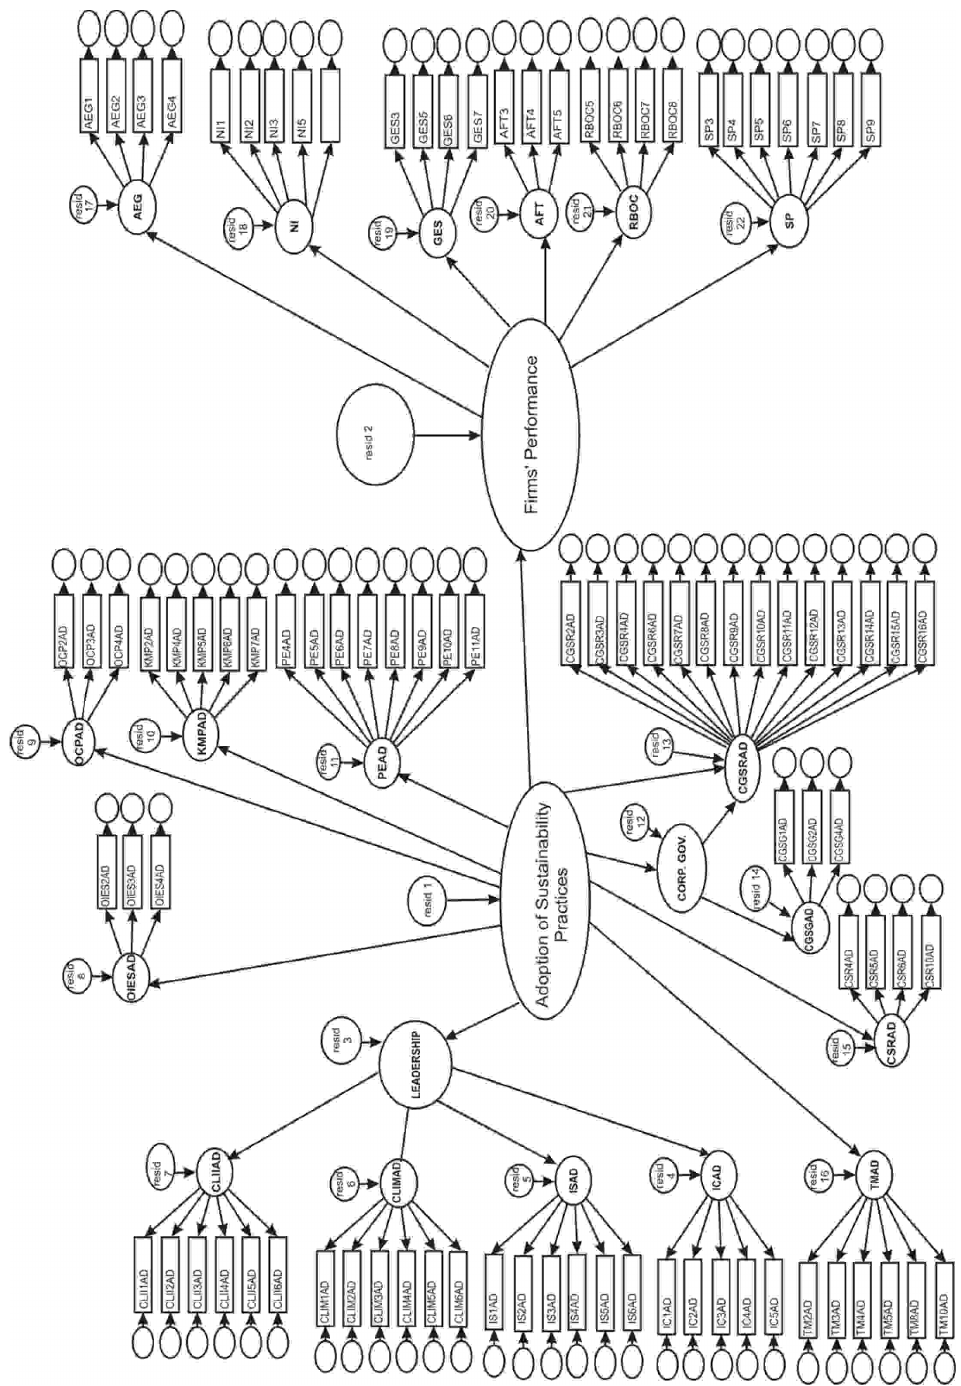
Fig. 3. Hypothesized structural equation model for predicting the performance of construction firms from the adoption of sustainability practices (developed by the